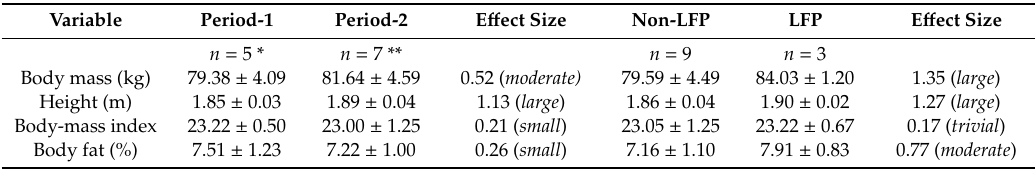
Table 1. Comparison of the anthropometric profile of goalkeepers in Period-1 (2008 / 2009–2012 / 2013) with that of goalkeepers in Period-2 (2013 / 2014–2017 / 2018) and of Spanish non-LFP players with that of Spanish LFP players (2008 / 2009–2017 / 2018).